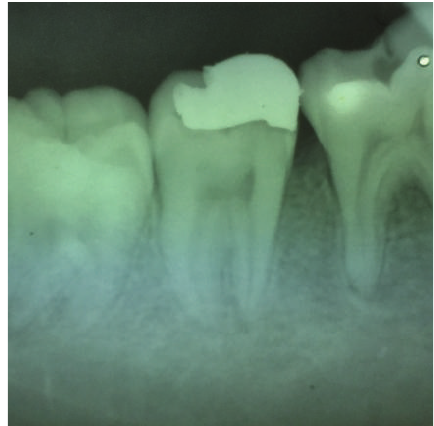
Figure 25: Postobturation radiograph of